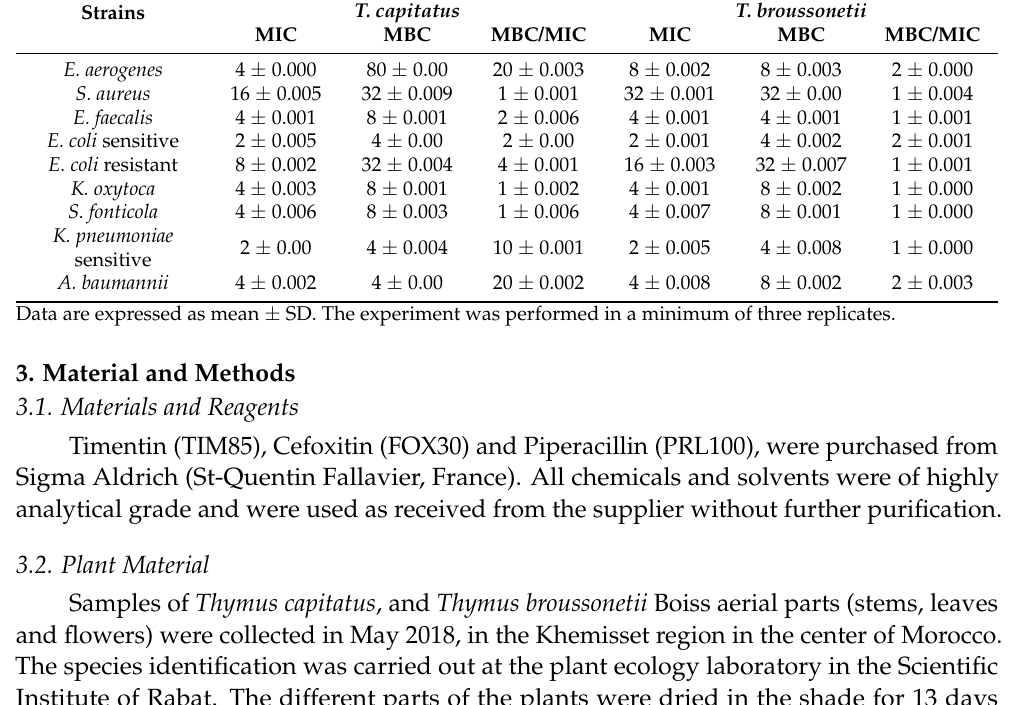
Table 3. Minimal inhibitory concentration (MIC), minimal bactericidal concentration (MBC) and the MBC/MIC report values (mg/mL) of T. capitatus and T. broussonetii EOs. Essential Oils T. capitatus Strains